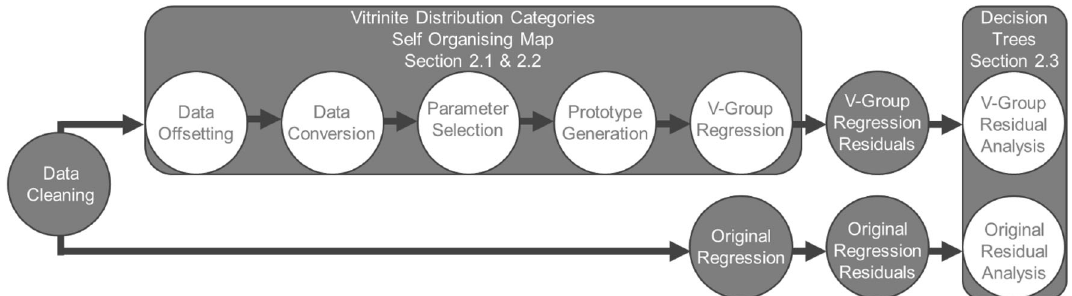
Fig. 2 Flowchart demonstrating overall